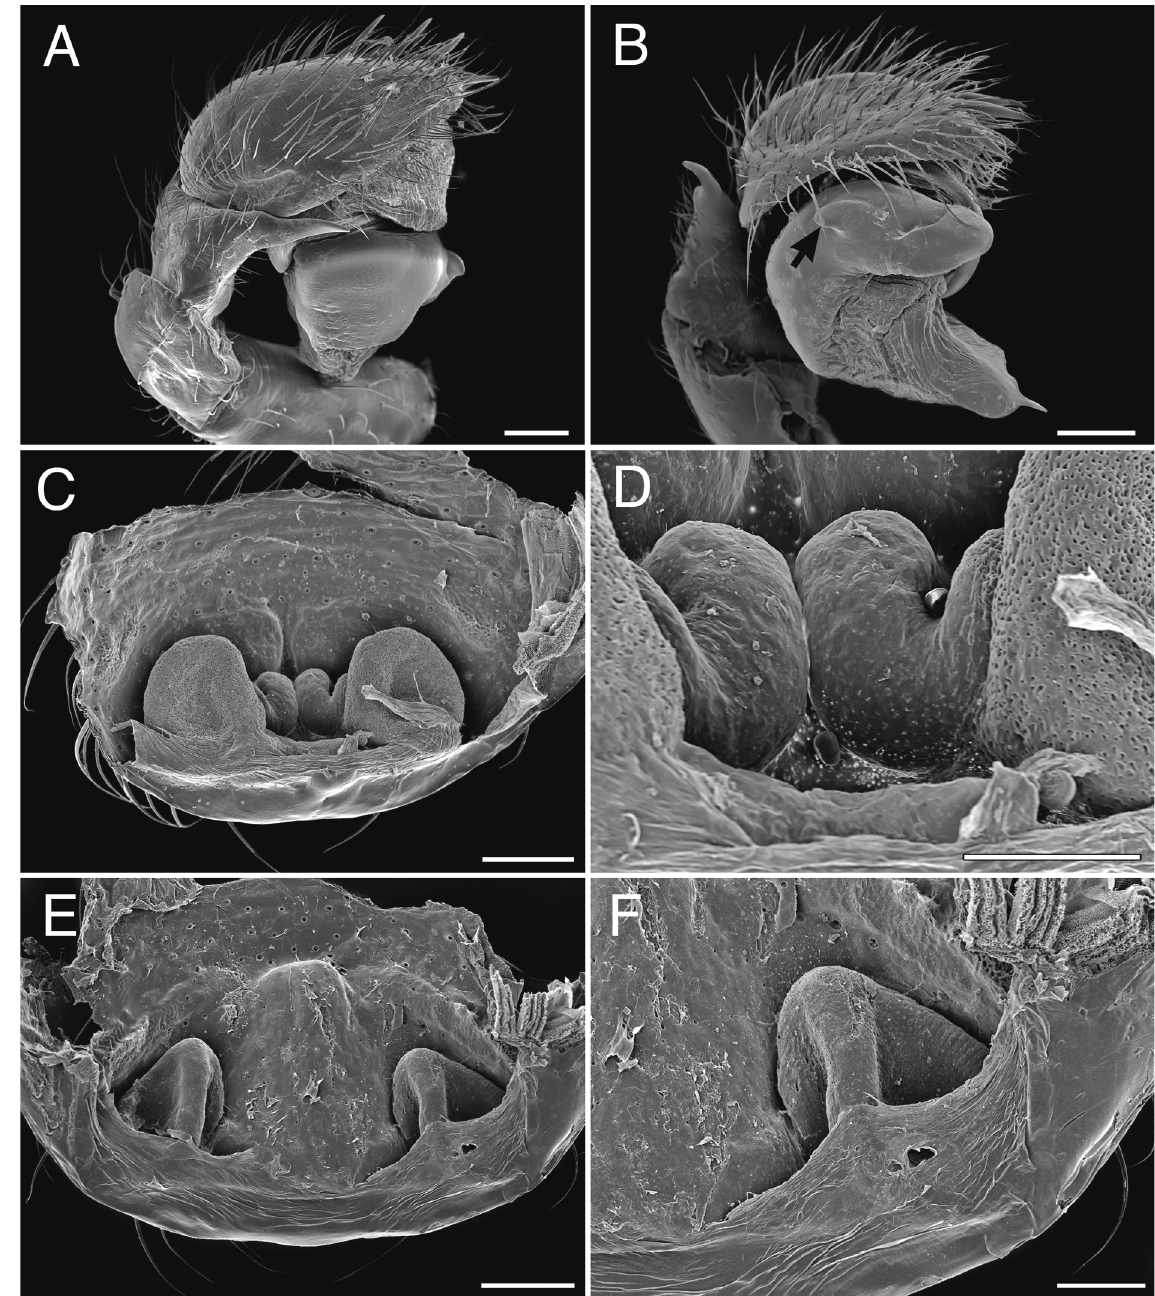
Fig. 2. — A–D . Palindroma morogorom gen. et s p. nov. Scanning electron miocrographs. A–B. ♂ from Kigogo Reserve. c-d. ♀ from Uzungwa Scarp Forest Reserve, paratype. A. ♂ palp, expanded, retrolateral view. B. Idem, anterolateral view. Arrow shows tegular retrolateral boss. c. epigyne, digested, dorsal view. d. Idem, detail. — E–F . Palindroma avonova gen. et sp. nov., paratype, ♀. E. Epigyne, digested, dorsal view F. Idem, detail. Scale bars: A–c, e = 200 mm, d, F =